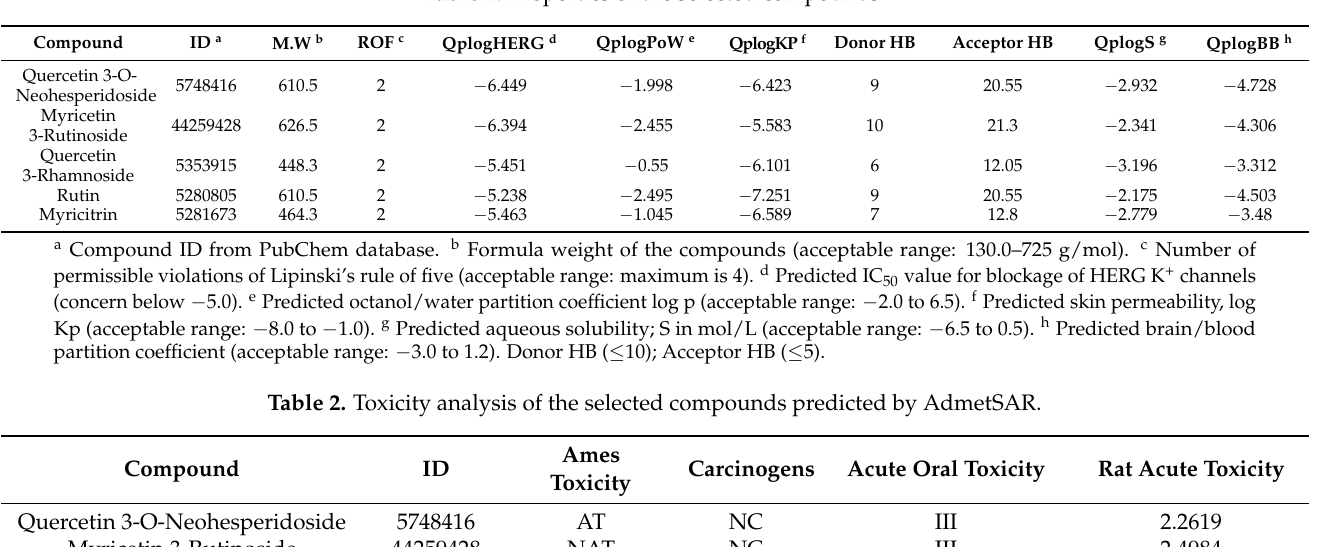
Table 1. Properties of the selected compounds.